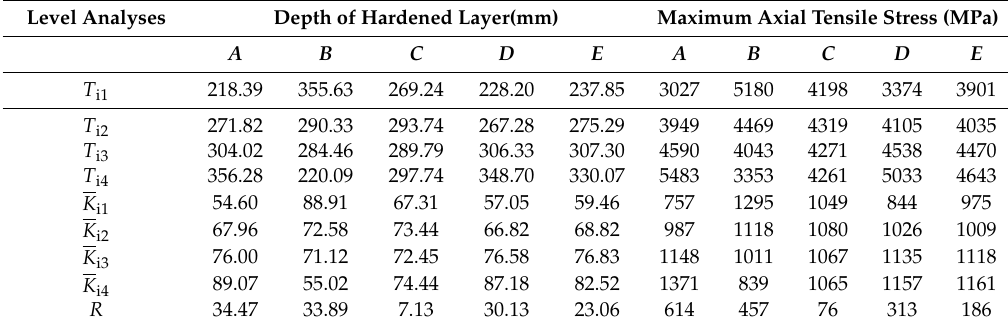
Table 5. Analysis of ranges of orthogonal